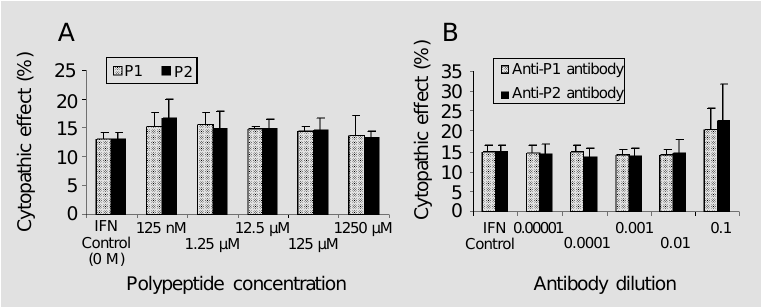
Figure 3 - Effect of polypeptides (A) and of their respective antibodies (B) on the antiviral a activity of IFN- B. Hep 2/c cells (3 x 10 5 /ml) were incubated with 0.125~1250 µM polypep- tides or serial dilutions of polyclonal antibodies in the presence of 2.5 nM IFN- before challenge with encephalomyocarditis virus. The cytopathic effect was determined by staining with amido blue black and absorbance reading at 620 nm.